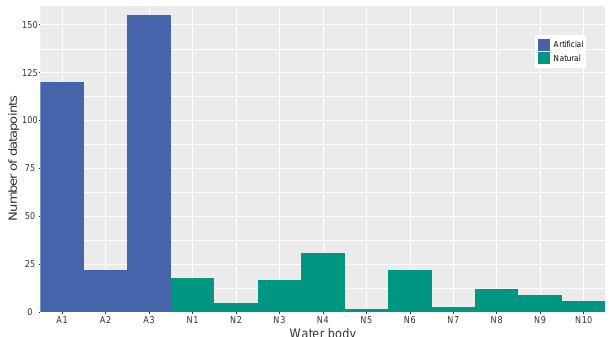
Figure 3. Number of datapoints per water body. The color defines the status of the water body: natural waters (green) and artificial ponds (blue).